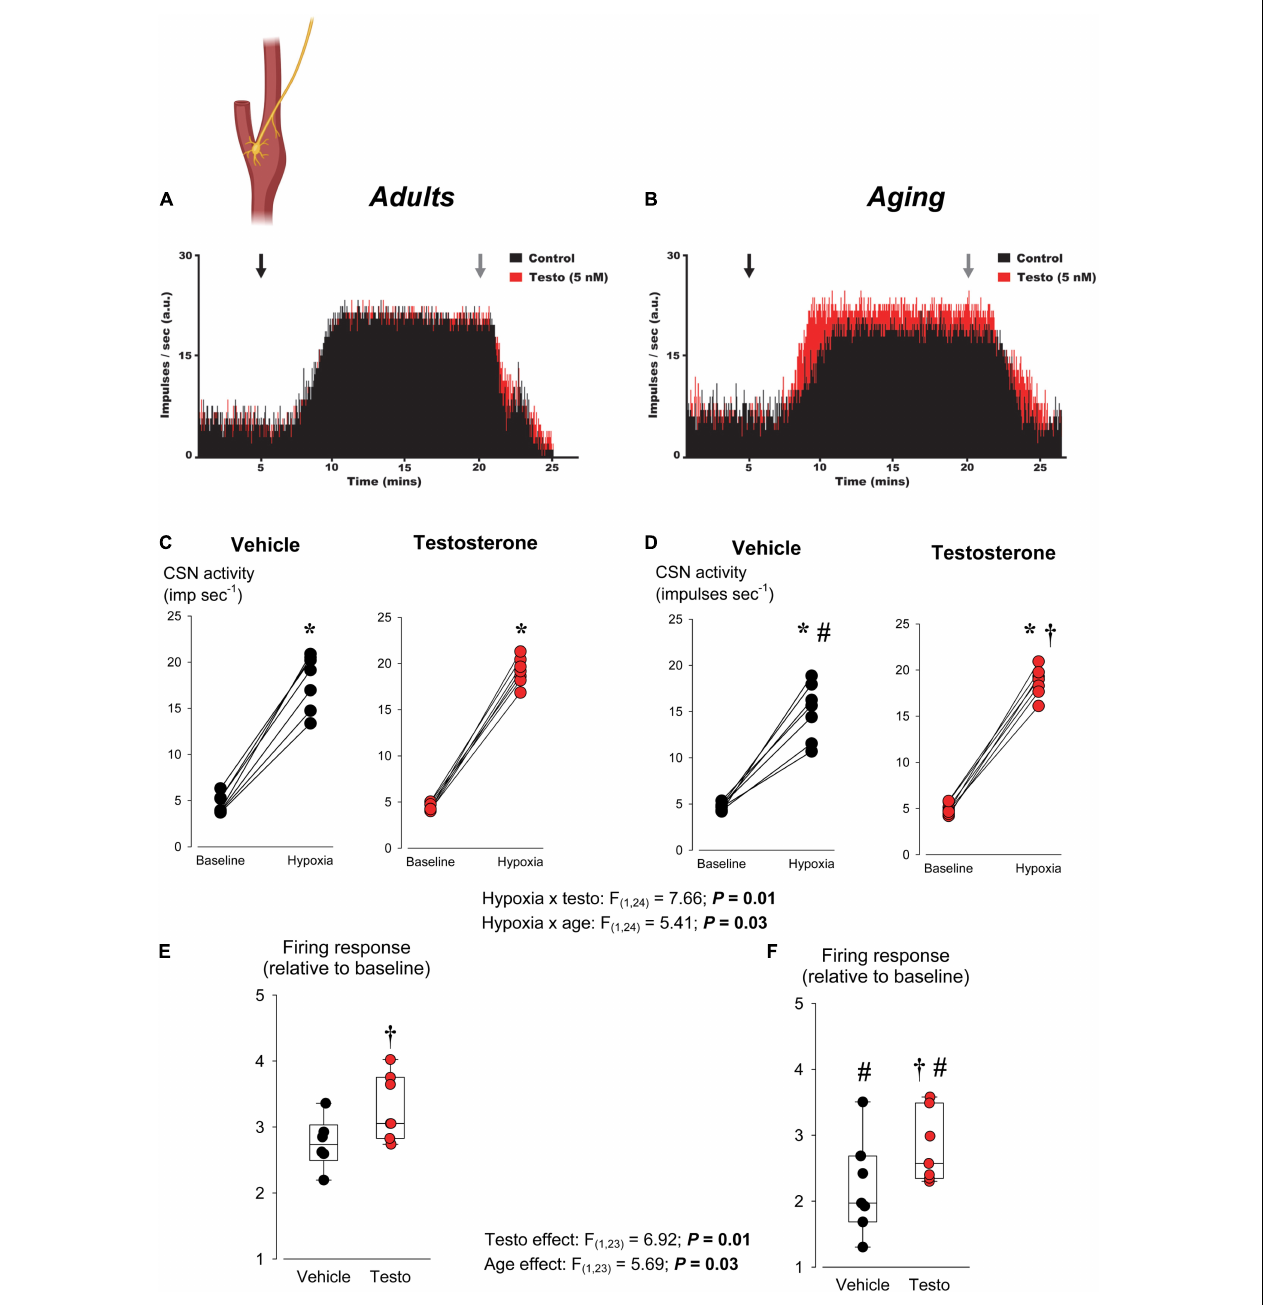
FIGURE 5 | Effects of age and testosterone on the carotid body’s response to hypoxia. (A) Representative electroneurograms (ENG) illustrating the rise in carotid sinus nerve (CSN) activity when the medium used to perfuse an ex vivo carotid body preparation is changed from normoxia (95% O 2 + 5% CO 2 ) to hypoxia (0% CO 2 + 5% CO 2 , balance N 2 ). Arrows indicate the time when medium is changed. Results were obtained from adult rats ( ∼ P70) preparations incubated either with vehicle ( < 0.001% DMSO; black ENG) or testosterone (5 nM; red ENG) 90–120 min prior to the onset of the experiments. Note that in those experiments, the responses (vehicle vs. testosterone) were nearly identical and the ENGs overlap. (B) Neurograms as in panel (A) comparing the effect of testosterone incubation on the responses from preparations obtained from aging rats ( ∼ 180 days old). Individual CSN activity (impulses sec - 1 ) from preparations from (C) adult or (D) aging rats under baseline conditions and during hypoxia; preparations were incubated with vehicle (black circles) or testosterone (red circles). Box plots show normalized firing rate responses (expressed as “fold-change” from baseline) for preparations from (E) adult and (F) aging rats incubated with vehicle (black circles) or testosterone (red circles). In each box plot, the boundary of the box closest to zero indicates the 25th percentile, the line within the box marks the median, and the boundary of the box farthest from zero indicates the 75th percentile. Whiskers (error bars) above and below the box indicate the 90th and 10th percentiles. N = 7 rats per group. * indicates a mean value significantly different from corresponding baseline value at P < 0.05; † indicates a mean value significantly different from the corresponding vehicle value at P < 0.05. # indicates a mean value significantly different from the corresponding adult value at P < 0.05.